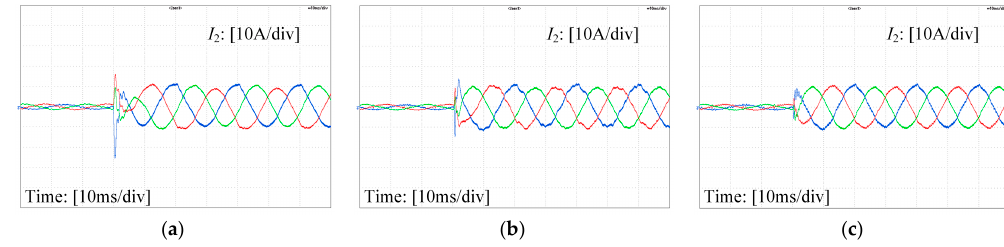
Figure 12. Grid-connected converter starting in inverter mode. ( a ) NFF; ( b ) SCVDFF; ( c ) DFPS-CVFF. When grid inductance L ’g = 0 and the current reference I * = 0, experimental results of the 2d grid-connected converter starting with NFF, SCVDFF and DFPS-CVFF are shown in Figure 13.